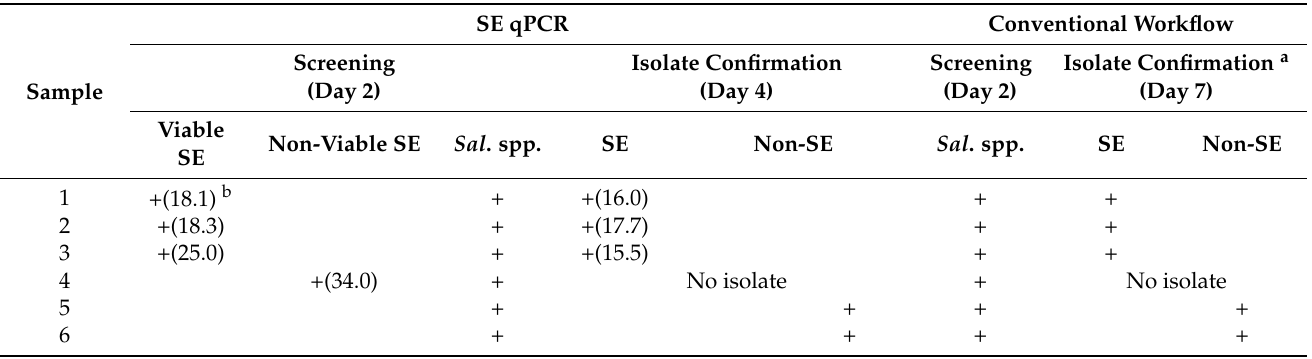
Table 4. Comparison of SE detection in naturally contaminated eggs using SE qPCR and conventional workflow for Salmonella